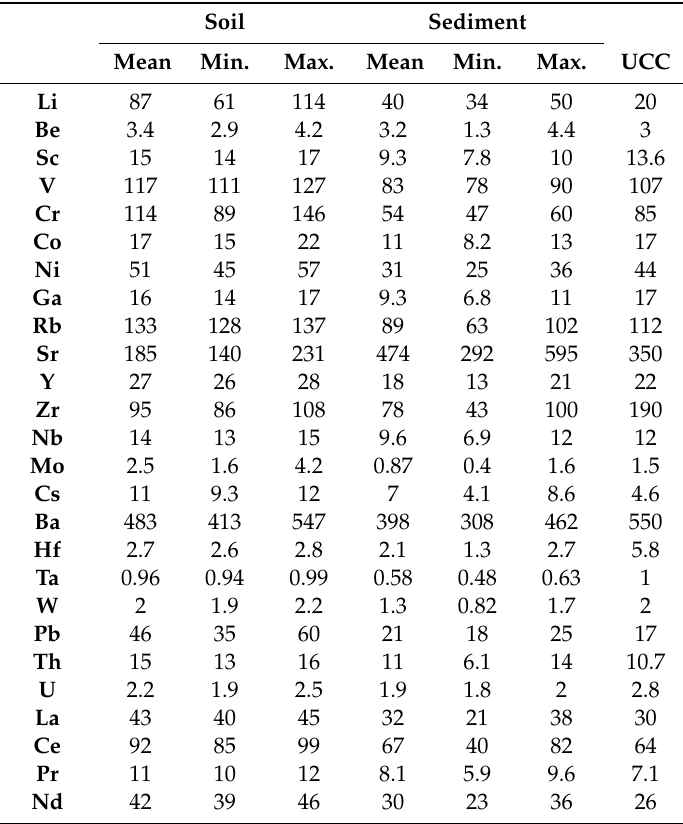
Figure 7. Vertical distribution of trace and rare earth elements (highlighted by gray shadow). The vertical lines connect the samples of Section A. Dashed horizontal lines indicate the different lithological units (abbreviation on the right). The main features of each single unit are summarized in Figure 4 and described in Section 3.1. LU4 (between LU5 and LU3) was not sampled. Table 3. Statistics of trace and rare earth elements (mg / kg). UCC refers to the average concentration of elements in the Upper Continental Crust